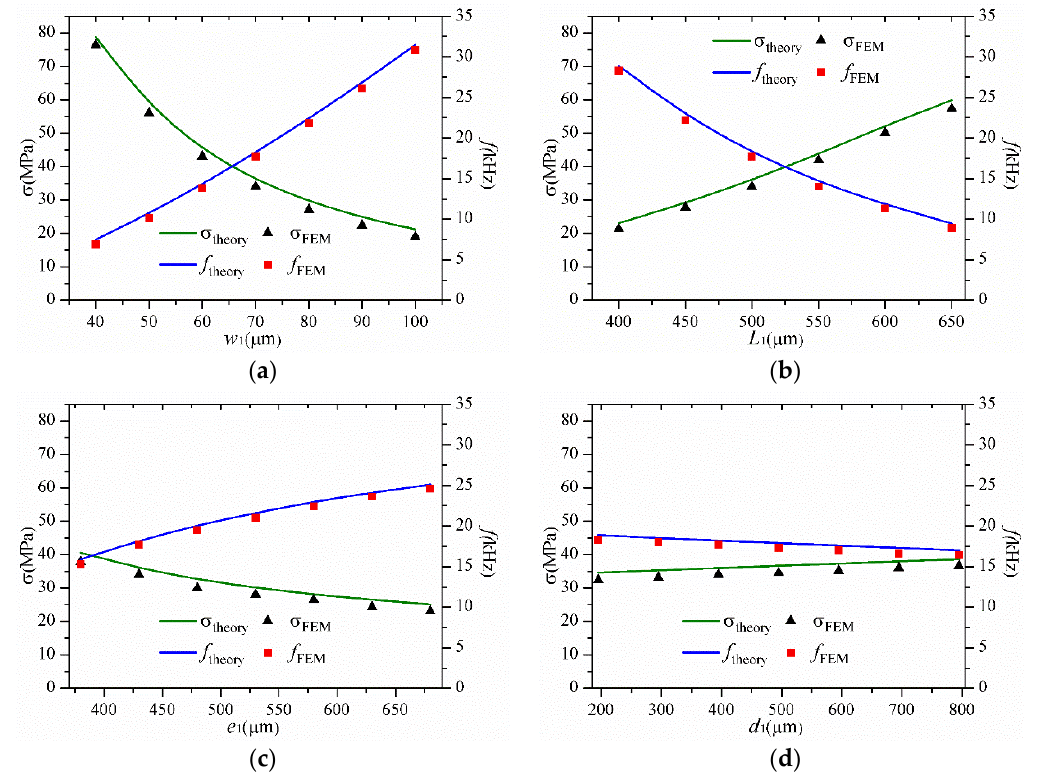
Figure 5 . Cont . Figure 5.